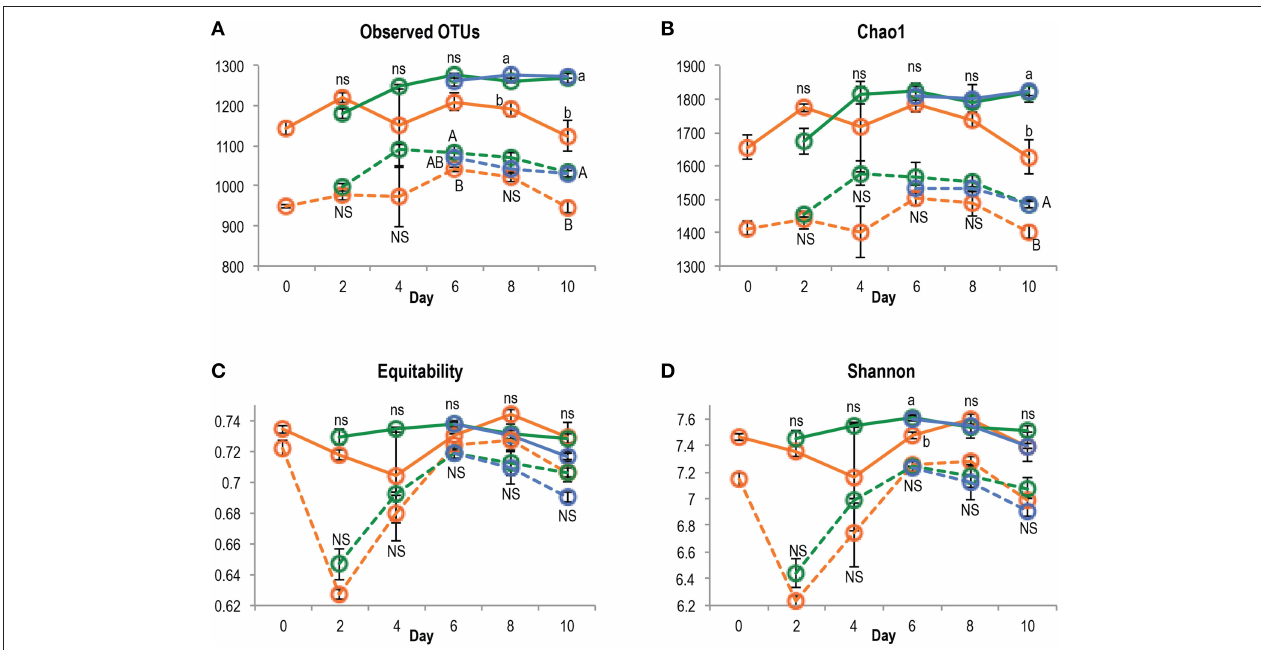
FIGURE 3 | Richness (A, number of OTUs; B, Chao1) and diversity (C, equitability; D, Shannon H ′ ) indices in bare (orange), bulk planted (green), and rhizospheric soil (blue), based on DNA or cDNA libraries (plain and dotted line, respectively). The effect of sample type was tested separately for each time point and nucleic acid using ANOVA followed by post-hoc Tukey test, and letters denote group with significant difference ( P < 0.05